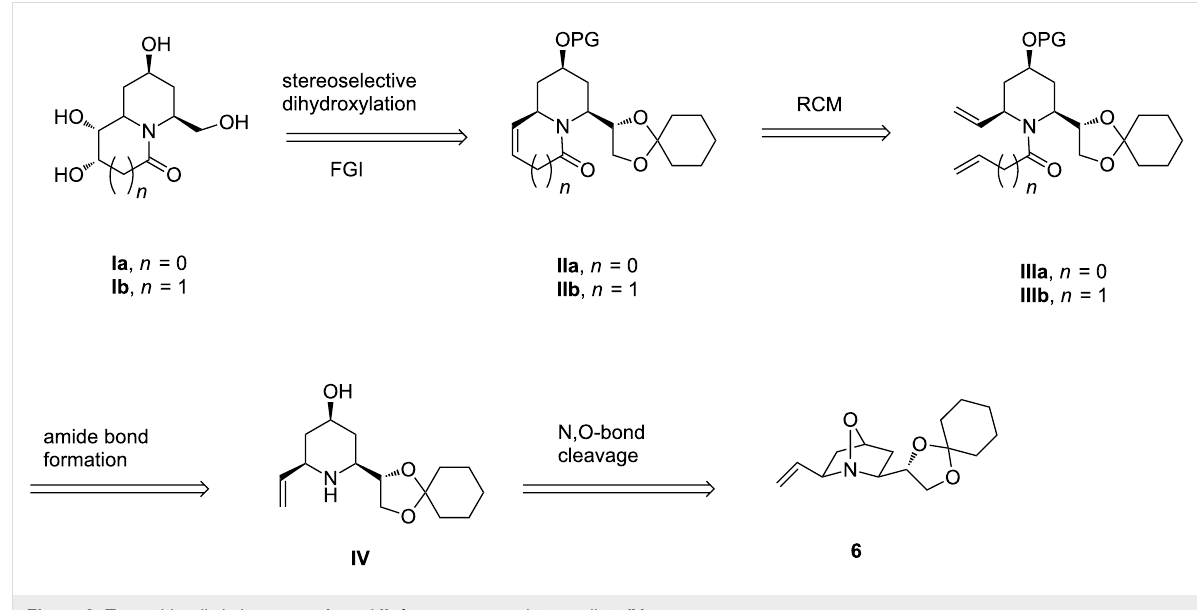
Figure 2: Target bicyclic imino sugars Ia and Ib from a common intermediate IV